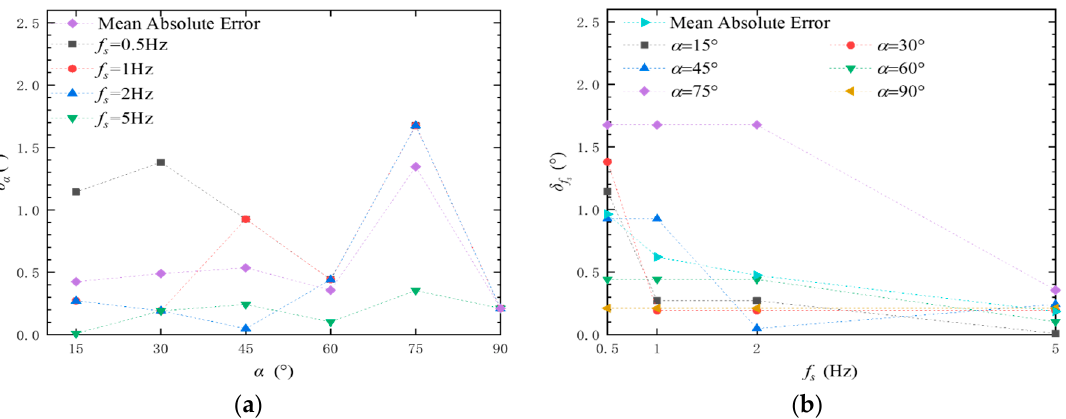
Figure 5. Estimation result of the attitude angle of a cube with a known size. ( a ) Variation of the absolute error of the attitude angle with the attitude angle. ( b ) Variation of the absolute error of the attitude angle with the spin rate.